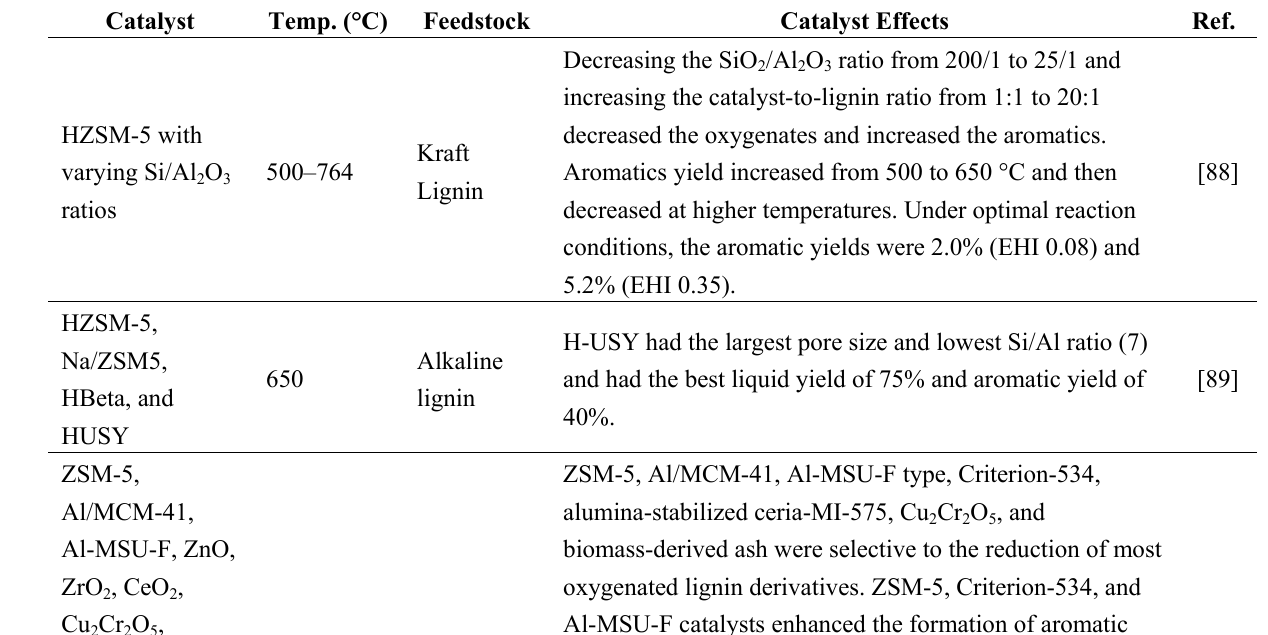
Table 3. Summary of catalysts investigated for zeolite cracking. Catalyst Temp. (°C) Feedstock Catalyst Effects